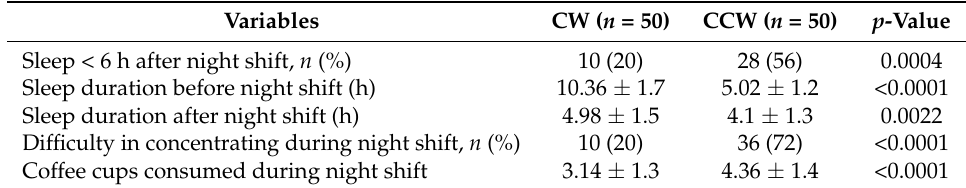
Table 3. Sleep features and work performance with respect to the night shift in the CW (clockwise) and CCW (counterclockwise) rotating